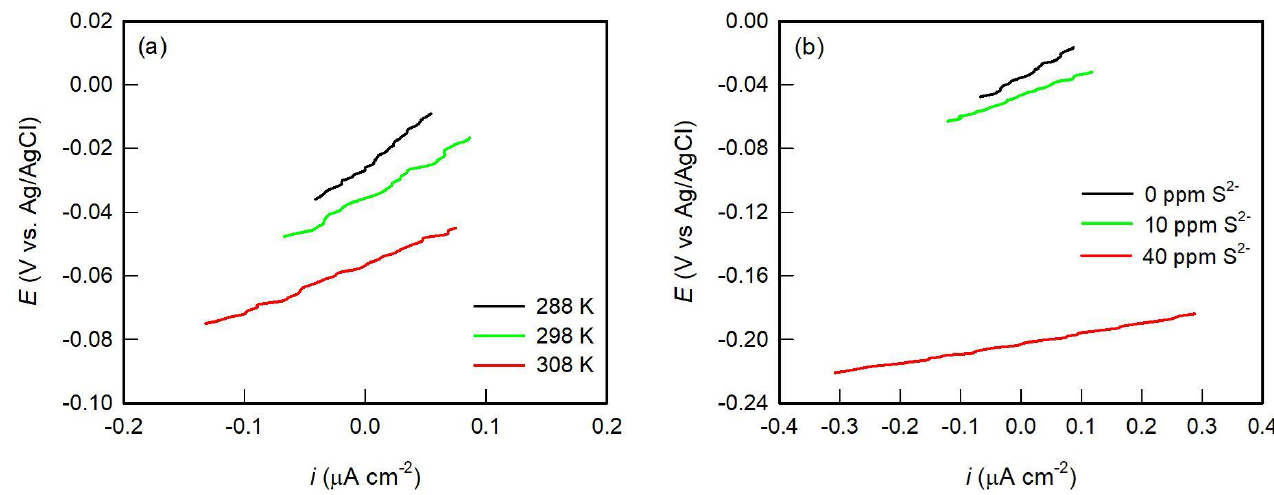
Figure 1. Open circuit potential curves for AISI 316L stainless steel in seawater at different ( a ) temperatures and ( b ) S 2− concentrations (at 298 K).